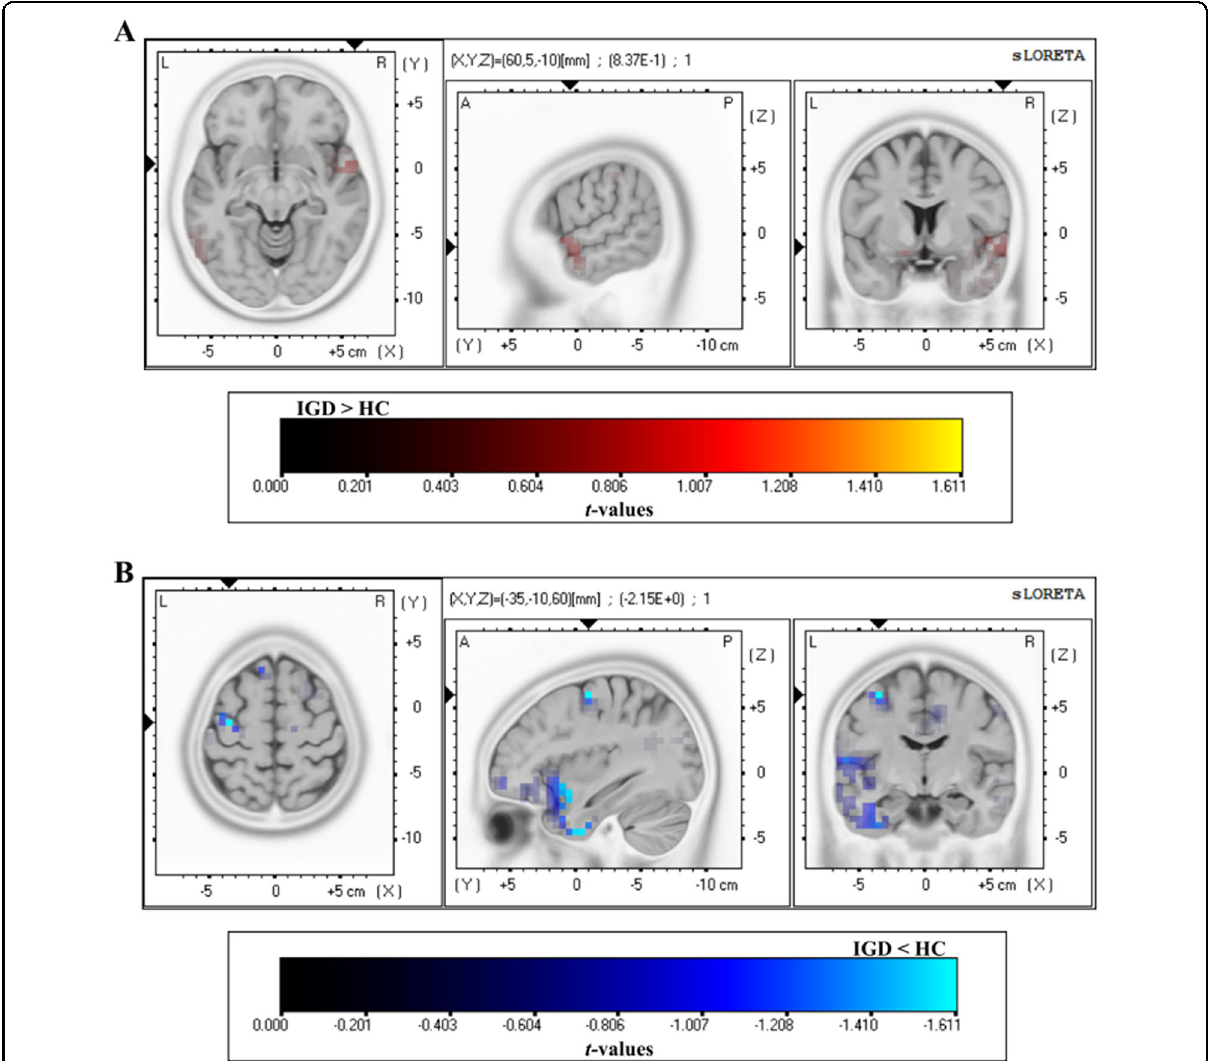
Fig. 2 Source localization comparing the current density of the Internet gaming disorder and healthy control groups for the game-related cues in the LPP time range. A More activation in the Internet gaming disorder group than the healthy control group and B less activation in the Internet gaming disorder group than the healthy control group. The cortical areas show signi fi cant differences at the <0.01 level (corrected for multiple comparisons). A, anterior; L, left; P, posterior; R, right. A summary of all signi fi cant regions can be found in Supplementary Table